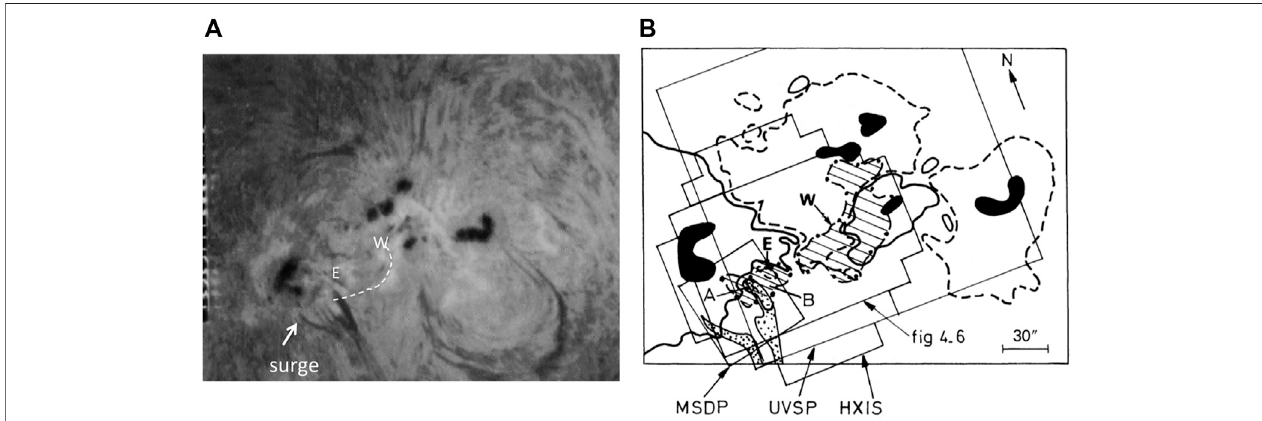
FIGURE 1 | Surge in H α observed on 11 November 1980, with the Solar Optical Observations Network (A) and all the signatures of the event obtained by the instruments (UVSP, HXIS) on board the SMM (B) . The surge in H α from the MSDP operating in the Meudon solar tower and in O V from the UVSP is indicated by the dottedarea, thebrightH α areas at its footpoint bytheletters Aand B,thehatchedarearepresentsthefootpoints(E, W)ofaloopobserved insoftX ray (3.5 – 5.5 eV)with HXIS and Fe XXI with the UVSP. The EW loop is drawn with a dashed line in the H α image [adapted from Schmieder et al.